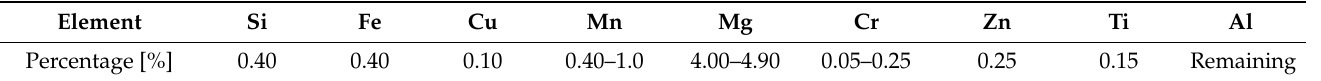
Table 1. Chemical composition of EN AW 5083 [9].